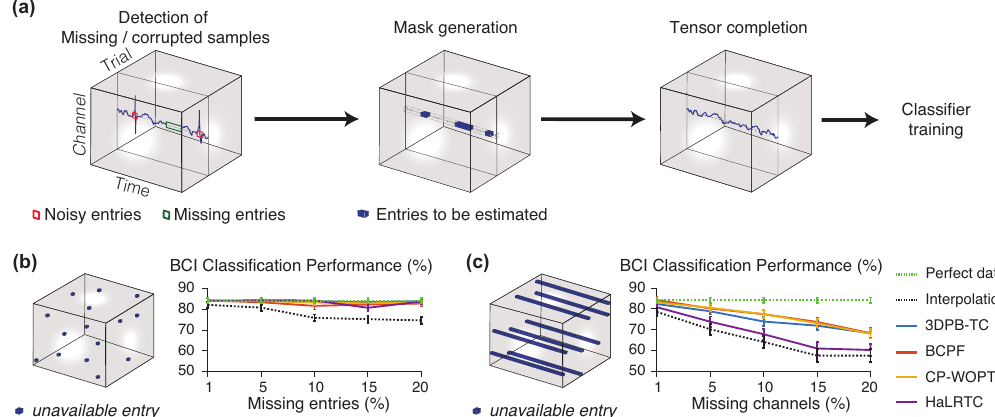
Figure 2. Training a BCI classifier (LDA) with noisy/missing EEG measurements. ( a ) Preprocessing steps: first, the positions in which the data is missed/corrupted are identified; then, a mask is created to ignore values in those positions; and finally, the tensor model reconstructs the missing data. ( b ) Results with randomly missing entries. ( c ) Results with random missing channels. (Figure adapted from